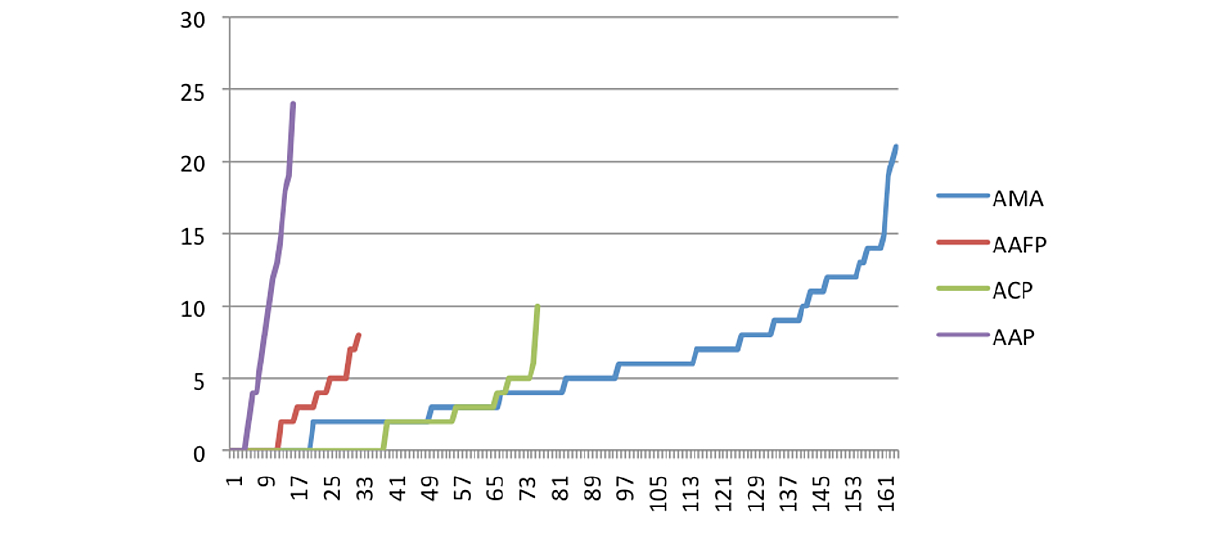
Figure 5. Number of retweets for messages sent in August 2012. [American Medical Association (AMA), American Academy of Family